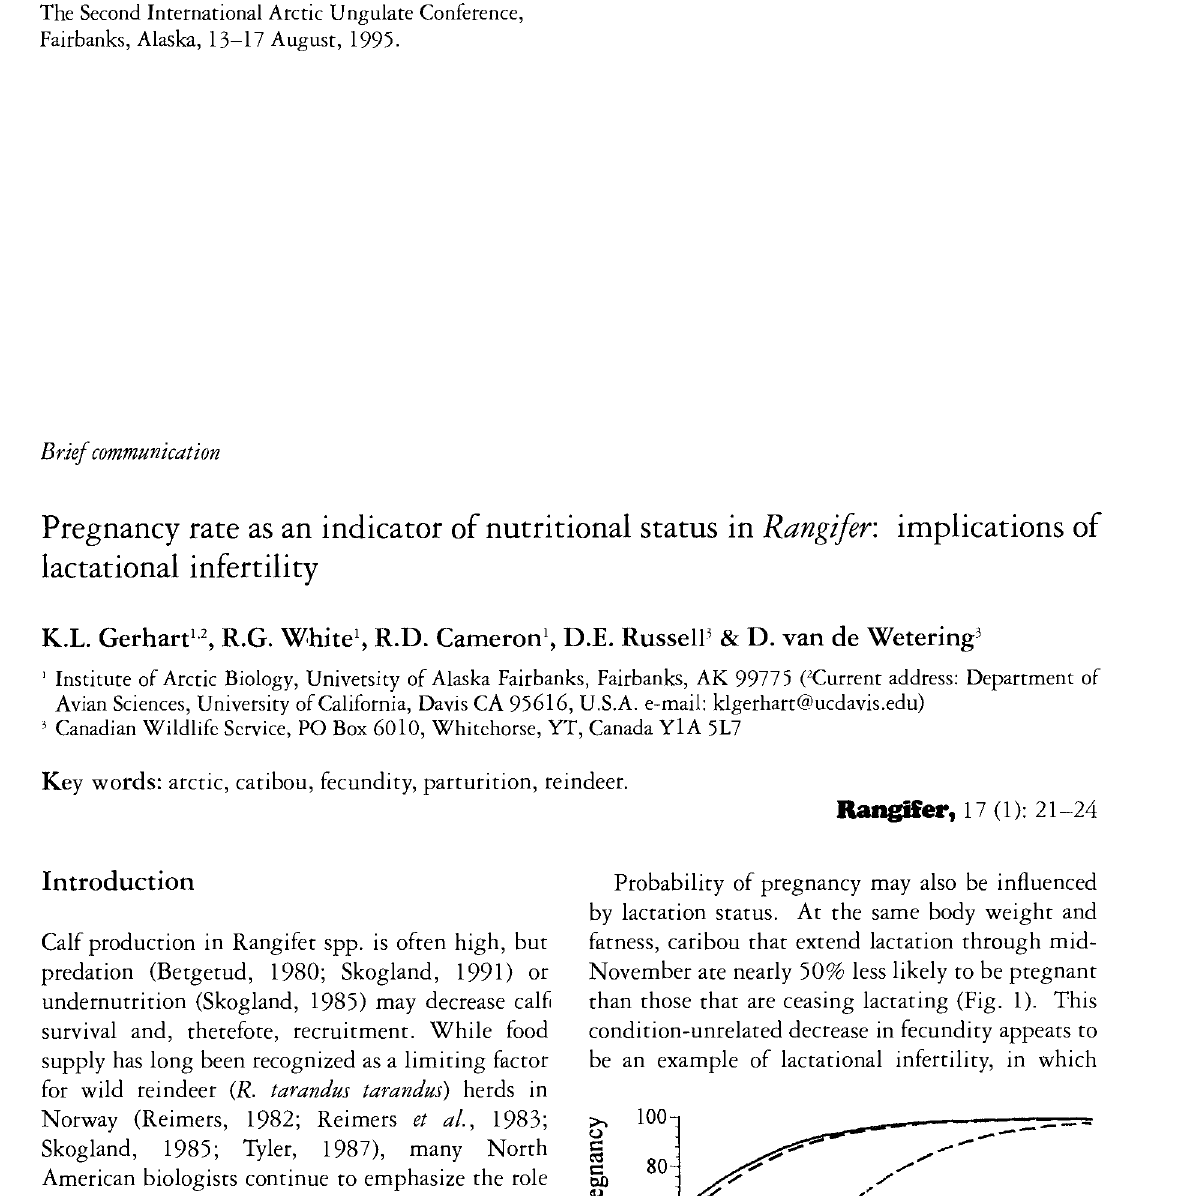
1. Probability of pregnancy in relation to body fat content and lactation class for adult female cari bou of the Porcupine herd. (Adapted from Fig. 2, Gerhart etal.,